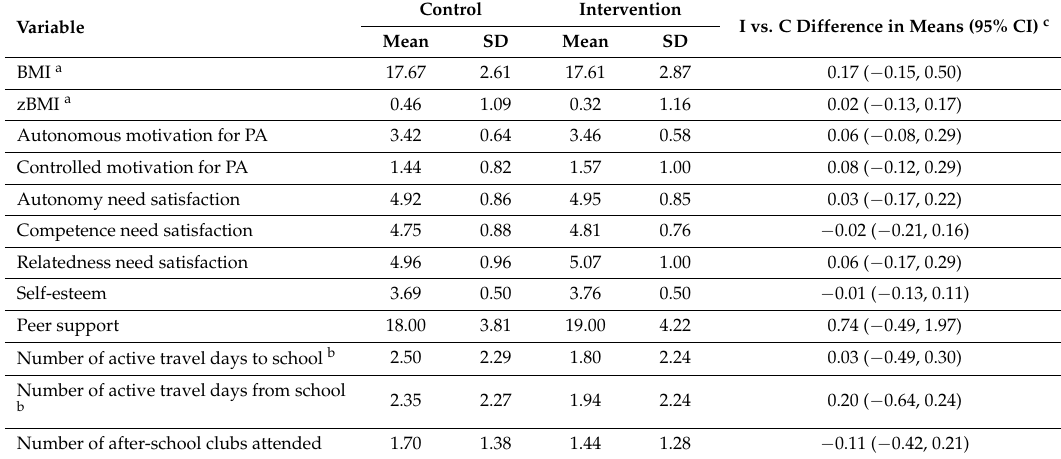
Table 3. BMI and questionnaire-derived secondary outcomes at